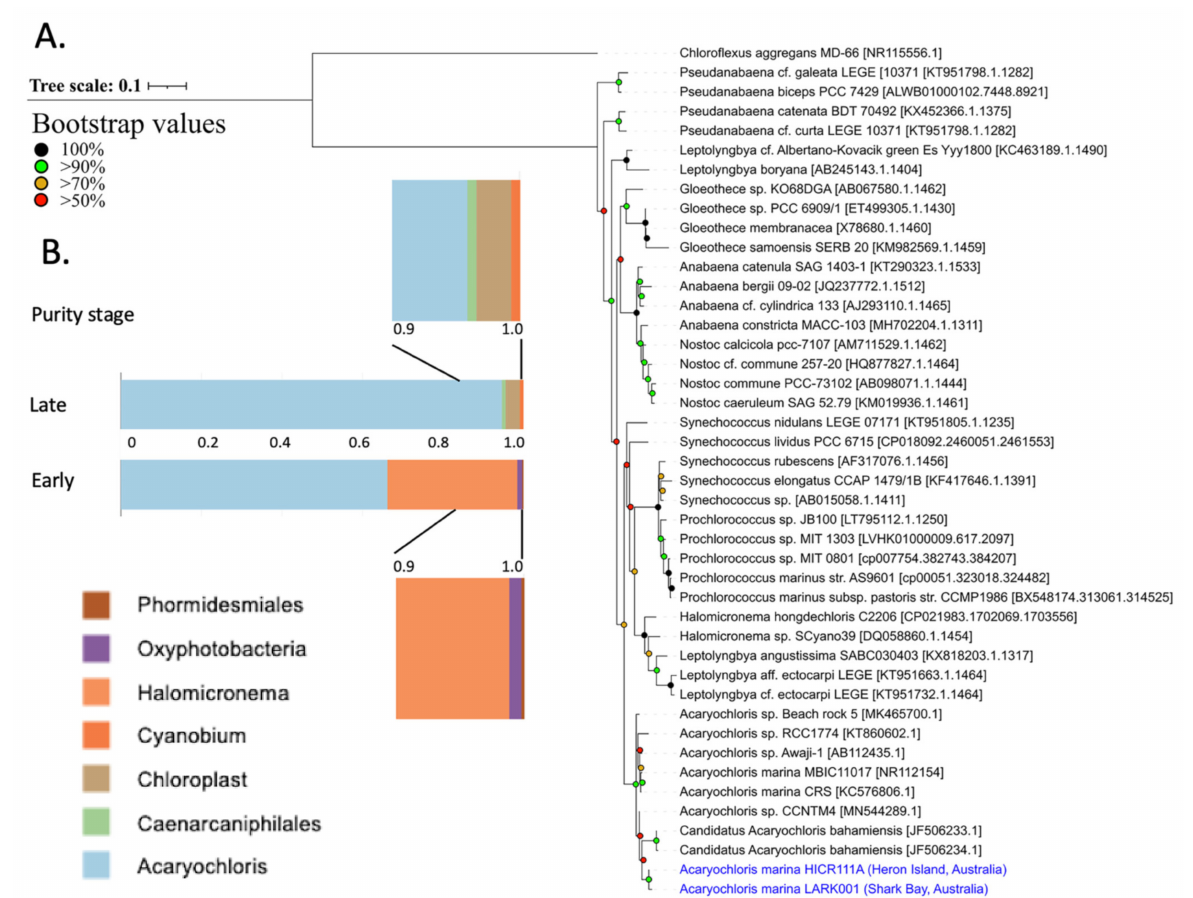
Figure 3. 16S rRNA sequencing. ( A ) 16S rRNA gene phylogeny of the LARK001 isolate from showing the relationship to other isolates. ( B ) 16S rRNA gene sequence representation of the LARK001 isolate at different stages of culture